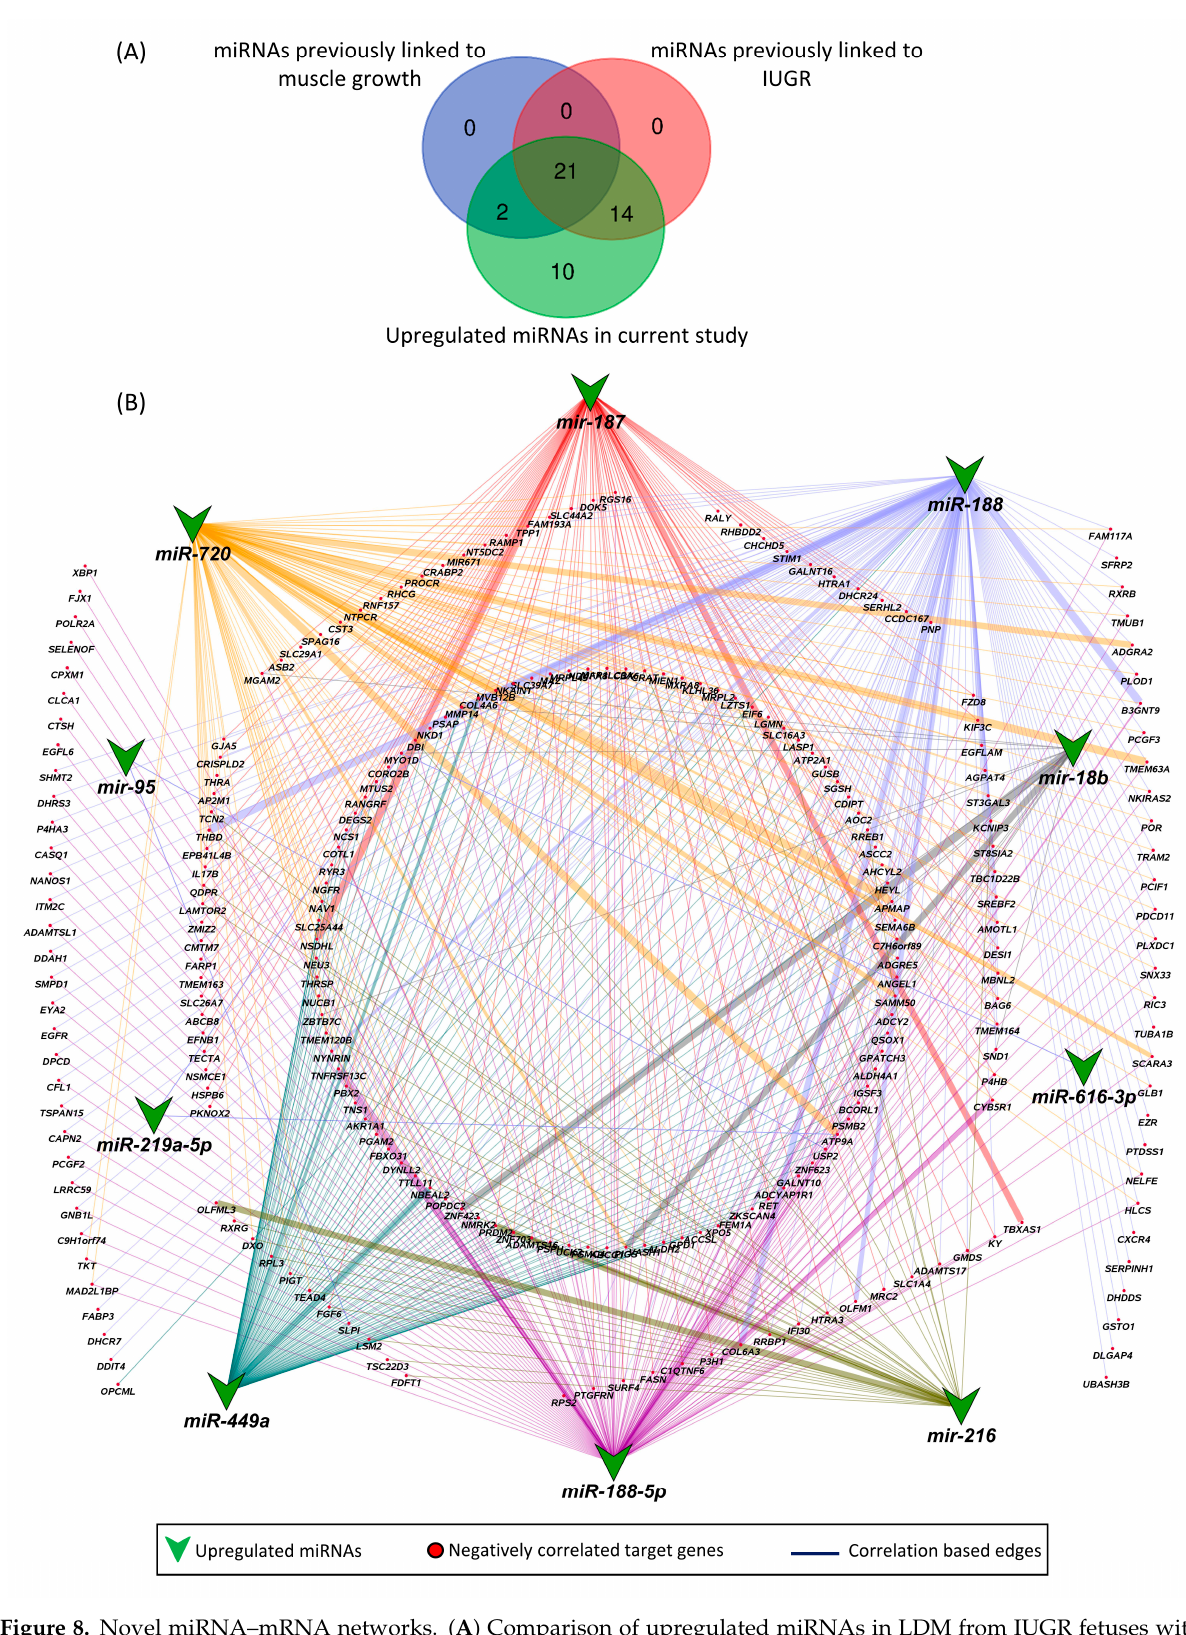
Figure 8. Novel miRNA–mRNA networks. ( A ) Comparison of upregulated miRNAs in LDM from IUGR fetuses with previously identified miRNAs associated with IUGR and skeletal muscle growth. ( B ) Correlation network between novel upregulated miRNAs and their negatively correlated downregulated target genes. A complete list of novel miRNA–mRNA pairs is provided in Table S5. Correlation coefficient in these pairs ranges from − 0.3 to 0.74.